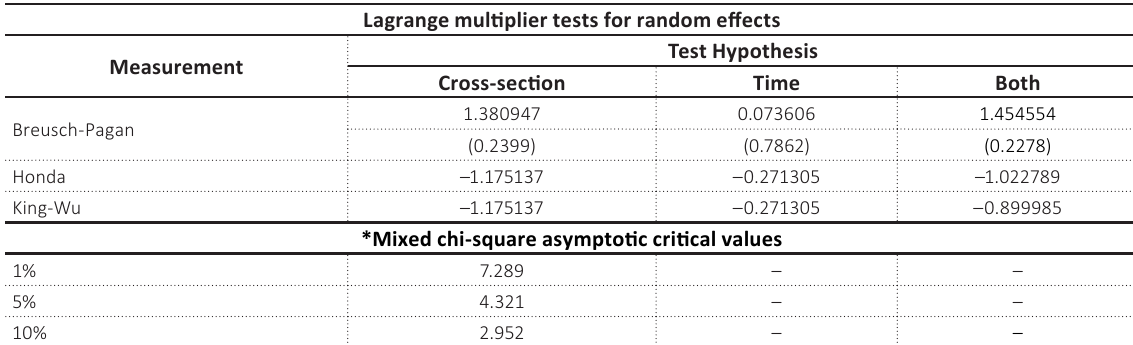
Table 5. LM test results of earnings management as a dependent